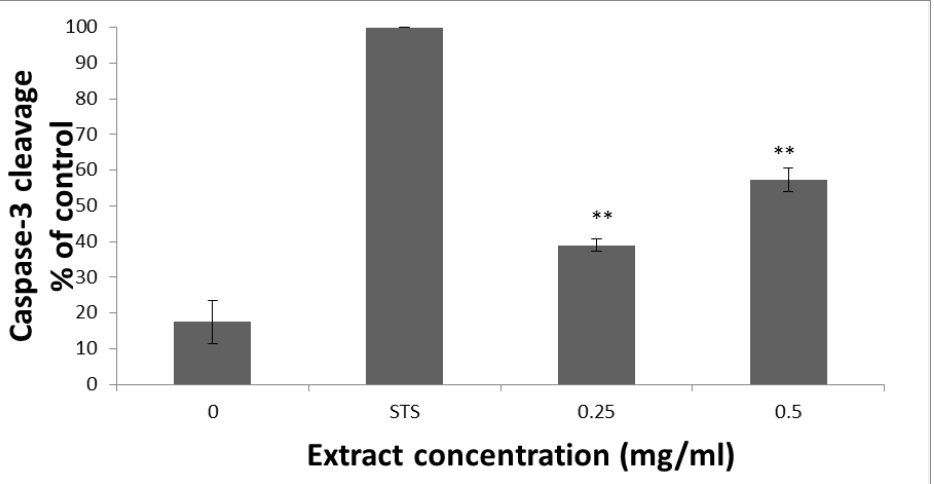
Figure 3. Determination of apoptosis induced by HTE in HCT-116 cells. Cells were exposed to the plant extract (up to 0.25 mg/mL) for 24 h. Apoptosis was determined using Acridine Orange (green) and Annexin-V CY3 (red) staining assay and was monitored by a fluorescence microscope. Apoptosis is expressed as a percentage of treated cells to untreated cells. ( A ) Values represent the mean ±SD of three independent experiments carried out in triplicates. * p < 0.05, ** p < 0.01, significant as compared with controls. ( B ) Representative fluorescence microscopy images showing co-staining with Acridine Orange and Annexin-V CY3. ( C ) Chemical structures of the detected putative apoptotic inducer compounds.